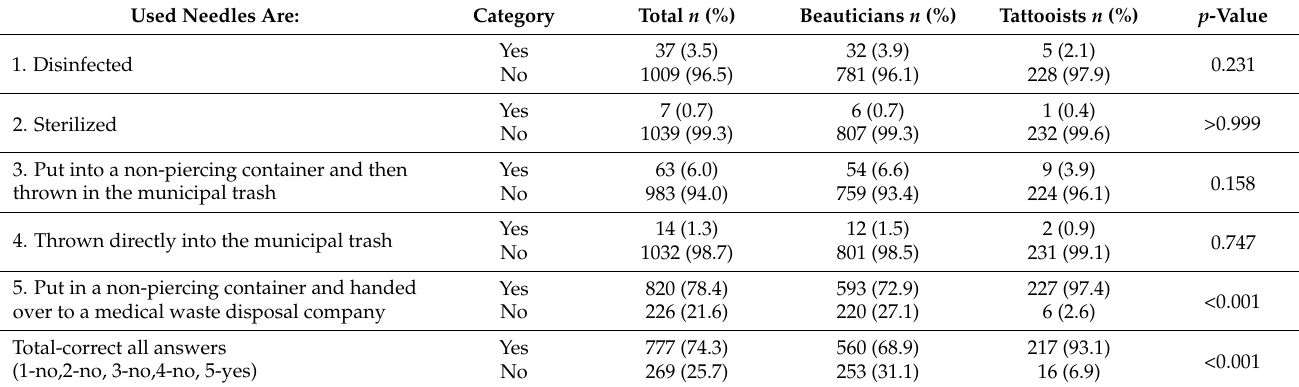
Table 4. Handling of used needles by beauticians and tattooists.